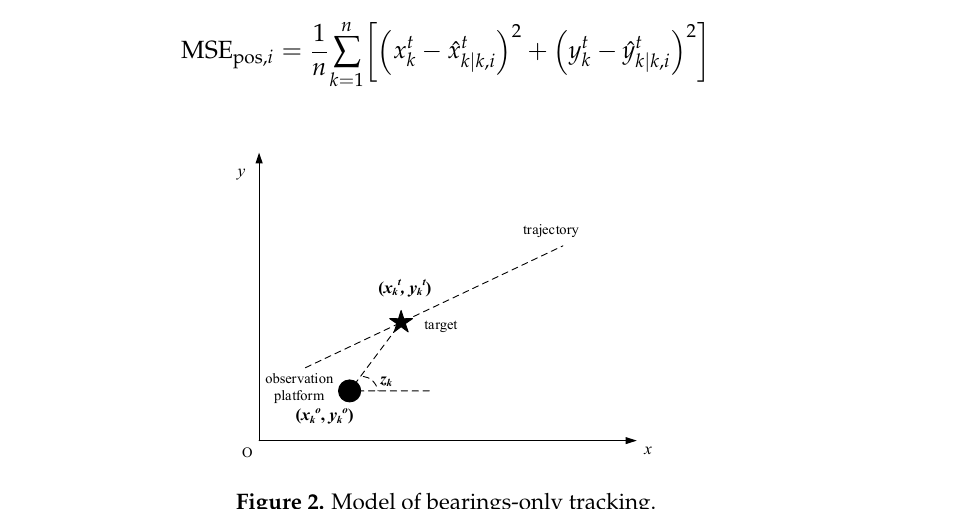
Figure 2. Model of bearings-only tracking.